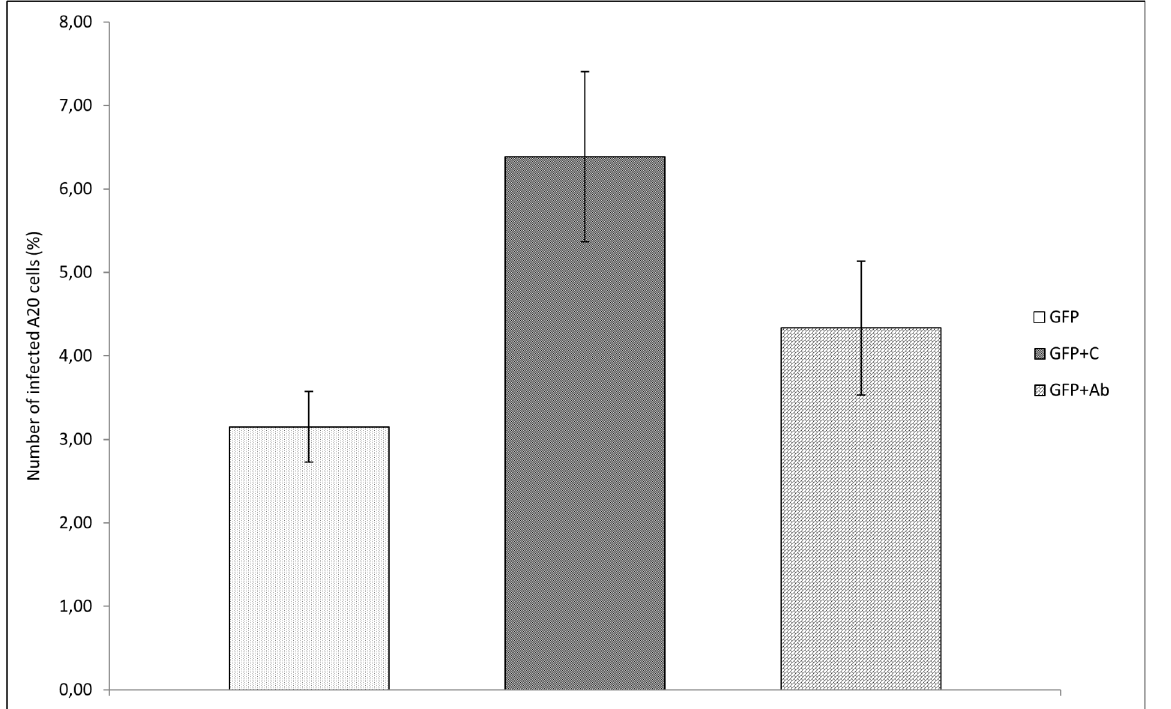
Fig 2. F . tularensis infecting A20 cells in vitro . Cells from the A20 mouse B cell line (5 x 10 5 per well in total volume 0.5 mL) were infected by F . tularensis LVS/GFP (GFP) opsonized with fresh uninactivated serum (GFP+C) from na ï ve mice and bacteria opsonized with heat-inactivated immune sera (GFP+Ab) at MOI 500. The cultures were then incubated at 36.8°C and 5% CO2 atmosphere for 3 h. Proportion of infected cells was determined by flow cytometry. Error bars indicate SD around the means of samples processed in triplicate. Two-tailed t -tests were used to test for significant differencess between GFP and GFP+C and GFP+iC and GFP+Ab ( *** P < 0.001, ** P < 0.01). Results shown from one experiment are representative of three independent